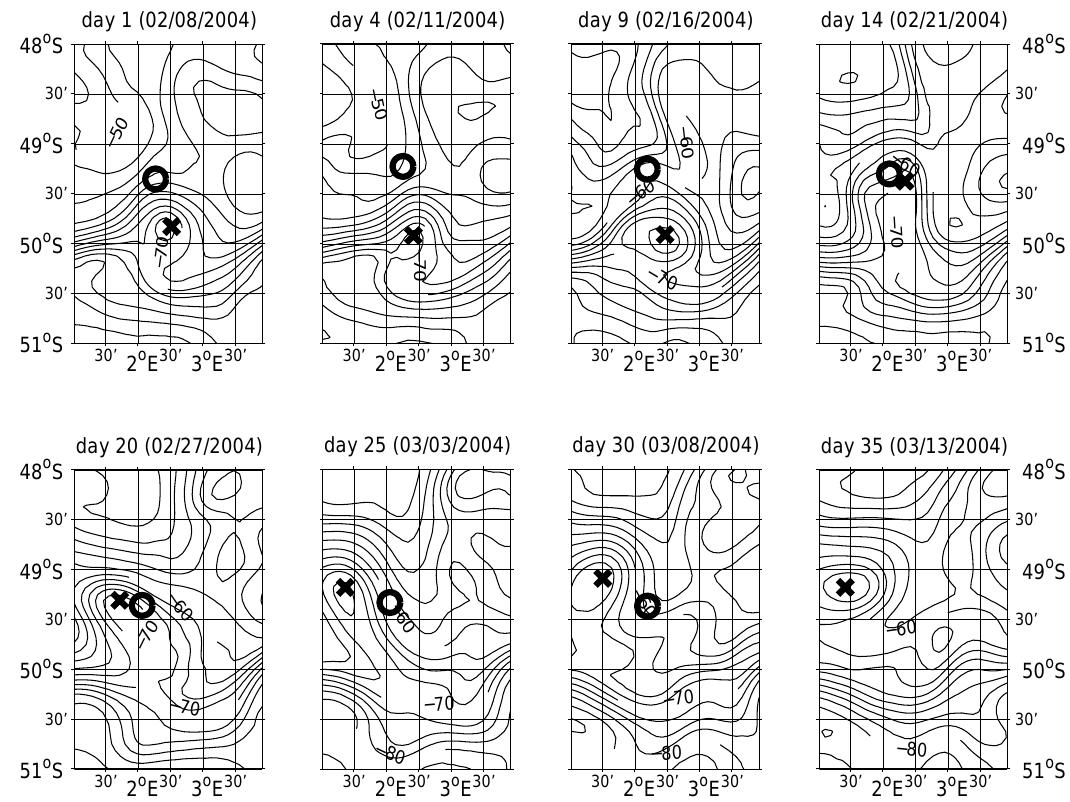
Fig. 1. NLOM SSH, contour interval is 2.5cm. The circles represent the eddy centers estimated from observed velocities, the crosses the eddy centers from the model velocities. The eddy center on day 35 could not be determined from